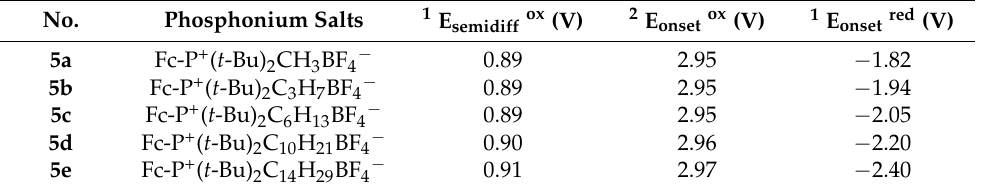
Table 6. Electrochemical properties of ferrocene-containing phosphonium salts. Conditions: room temperature, working electrode: glass-carbon, RE: Ag/AgCl, solvent: CH 3 CN a . No.